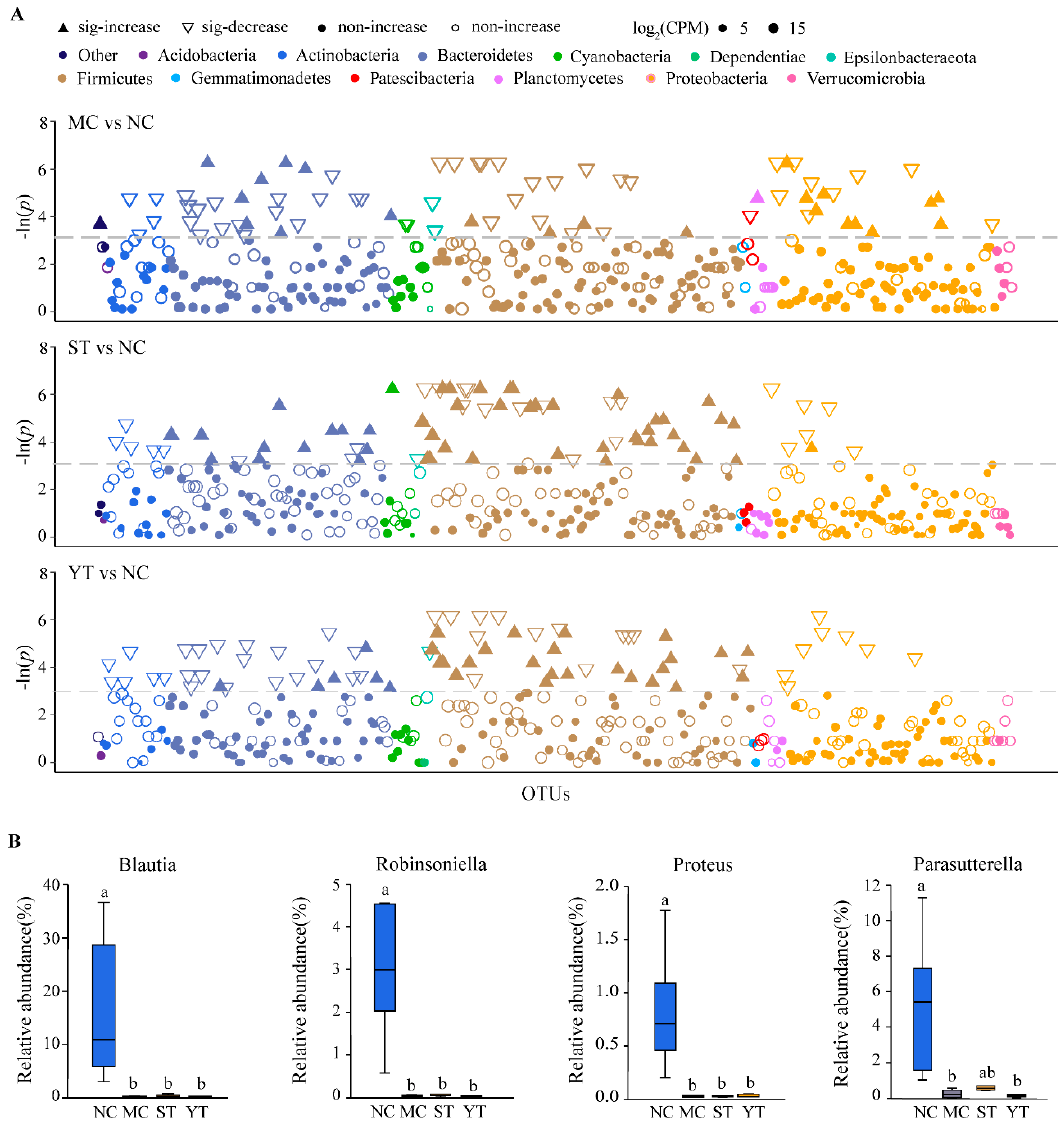
Figure 8. Di ff erent microbiota among the groups. ( A ) Manhattan plots showing enriched and depleted OTUs in MC vs NC, ST vs NC and YT vs NC at the phylum level. The dashed line corresponds to the false discovery rate-corrected p value (FDR) threshold of significance (Wilcoxon test, α = 0.05). The size of the point represents the relative abundance of the OTUs. The point identifies the type of changes, the shape of the solid triangle represents increased enrichment, hollow triangles represent the cut depleted, solid dots indicate increased with no significant di ff erence and hollow dots indicate decreased with no significant di ff erence. ( B ) Main di ff erent compositions at the genus level among NC, MC, ST and YT. Kruskal-Wallis test, Tukey HSD, FDR < 0.05. NC, Normal control group ( n = 6); MC, Model control group ( n = 6); ST, DMST-H2 treatment group ( n = 6); YT, yogurt treatment group ( n = 6). Significance was set as p < 0.05, and values that do not share a common letter di ff ered significantly ( p <